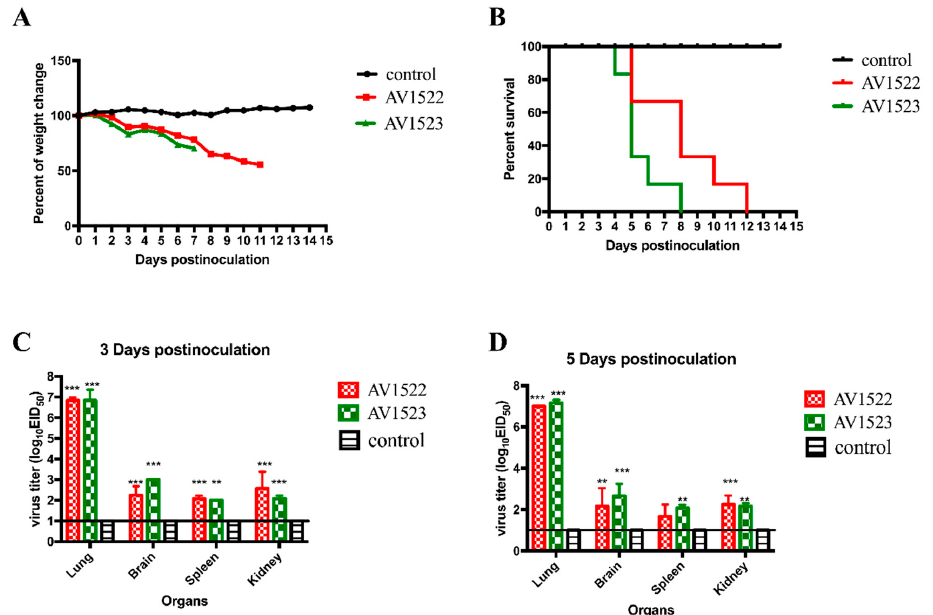
Figure 3. Weight change, lethality, and replication of the two H1N1 viruses in mice. ( A ) Weight change of BALB / c mice during the 14 days post-inoculation. Mice were inoculated intranasally with the doses of 10 6 EID 50 of the H1N1 viruses. Mice inoculated with phosphate bu ff er saline (PBS) served as a control group. ( B ) Lethality of the AV1522 and AV1523 viruses in BALB / c mice. ( C , D ) Three six-week-old SPF BALB / c mice inoculated intranasally with 10 6 EID 50 of each virus in a 50- µ L volume were euthanized at 3 DPI and 5 DPI, and their organs were collected for virus titration in eggs. For statistical analysis, a value of 1.0 was assigned if the virus was not detected from the undiluted sample in three embryonated hen eggs. Data shown are the mean virus titers ± standard deviation in log 10 EID 50 / mL of tissue. Error bars indicate standard